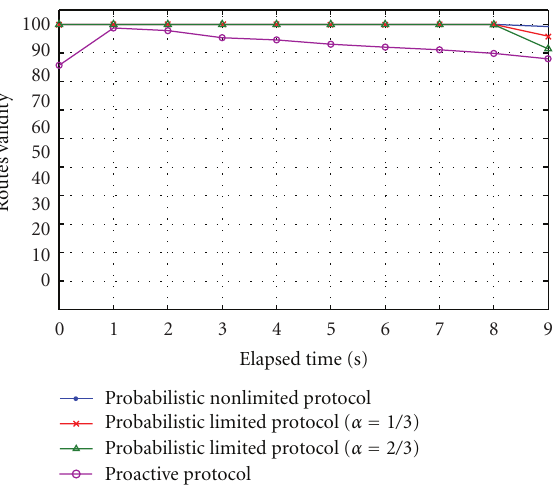
Figure 5: Percentage of valid probabilistic routes as a function of the elapsed time, V = 1m/sec.